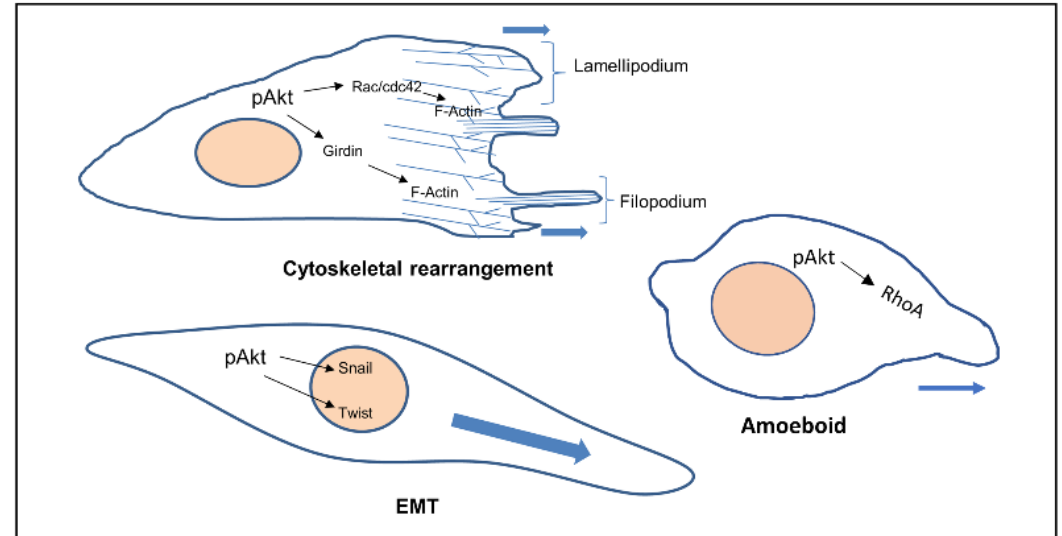
Figure 1. Cellular phenotypes during migration and the role of activated Akt. Activated Akt triggers the activity of downstream substrates (Rac, Girdin, Twist, RhoA) that dictate the various modes of cell migration.